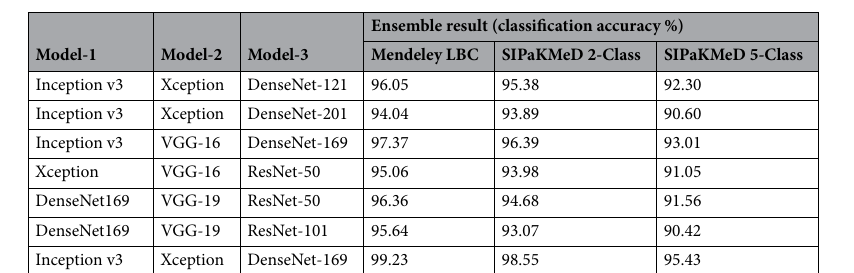
Table 5. Results obtained on ensembling various combinations of base learners on all the three datasets used in this